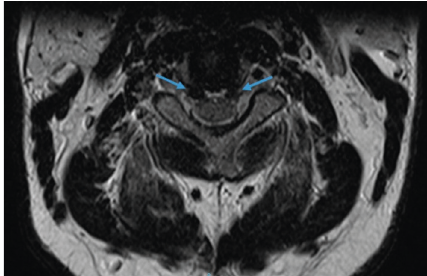
Figure 2: Contrast-enhanced MRI of the cervical spine, axial view. T2-weighted image: prominent epidural veins (blue arrows).